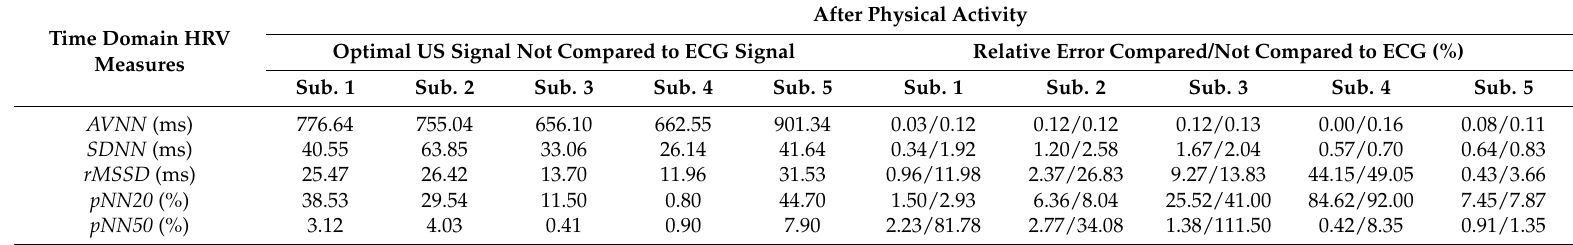
Table 6. Representative time domain values of HRV measurements in a 5 min data set, during relaxation, subject 1–5, part